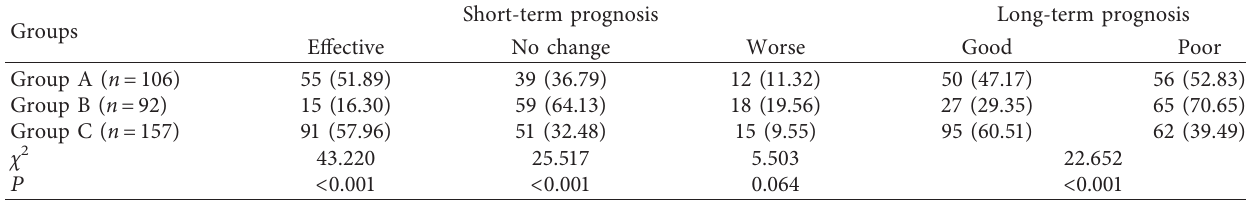
Table 1: Comparison of short-term and long-term prognosis among the three groups.